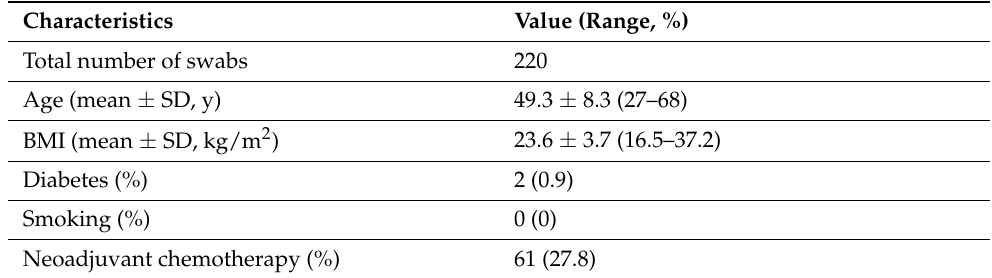
Table 1. Baseline characteristics of study